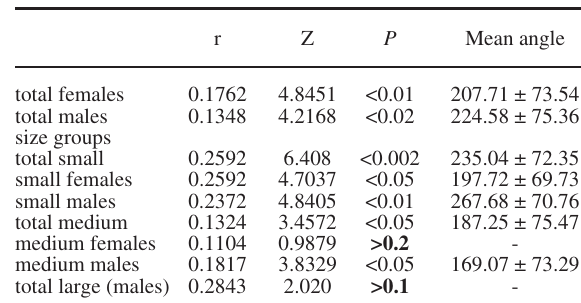
Table 3. – results of rayleigh’s test and mean angle taken by lobsters recaptured presented by sex and size categories (in bold significant P